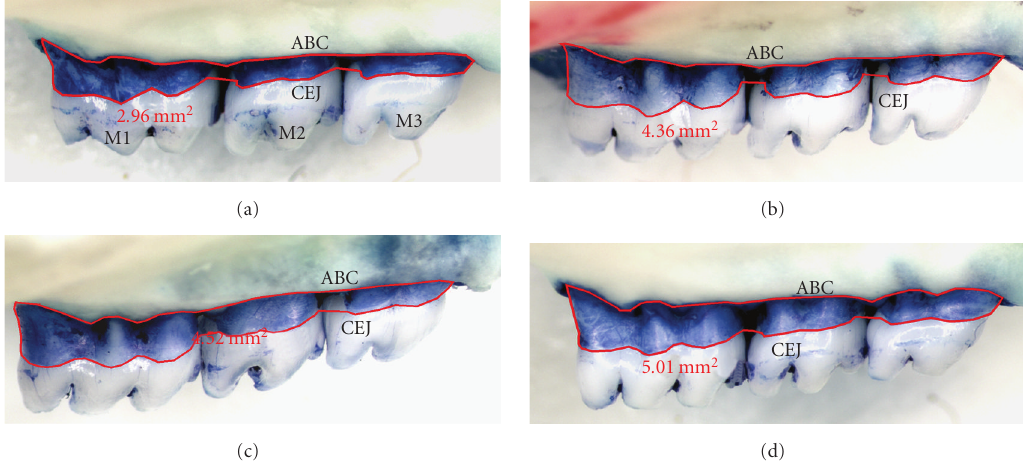
Figure 2: Morphometric evaulation of alveolar bone loss. Representative rat left maxilla of a sham-infected control rat (a) showing the buccal horizontal bone loss area by morphometry. The area outlined between CEJ-ABC represents the area of horizontal alveolar bone resorption in mm 2 (b). Rat left maxilla infected with P. gingivalis , (c) T. denticola , and (d) P. gingivalis + T. denticola during 12 weeks of periodontal disease showing extensive horizontal alveolar bone loss. M1, M2, and M3 are molars. Rat jaw images captured at 10 × magnification. Table 1: Morphometric measurements of horizontal alveolar bone loss (area) on the buccal and palatal surfaces of all molars in rats. Infection/Groups Control P.